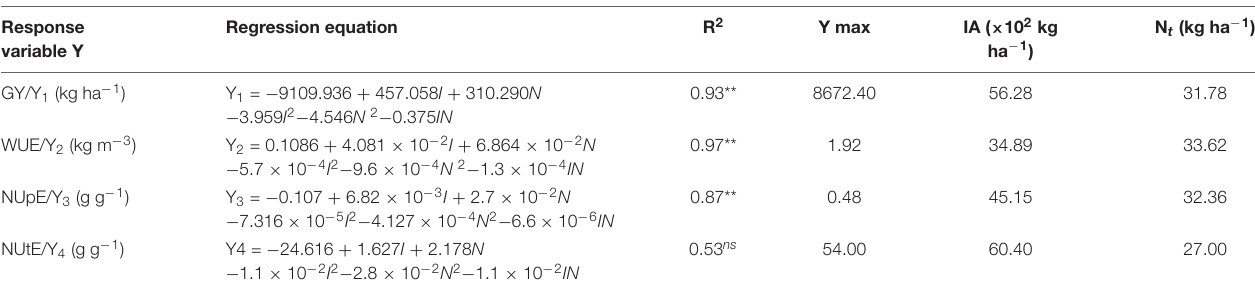
TABLE 8 | Regression equation between water and nitrogen input and GY, WUE, NUpE, and NUtE. Response variable